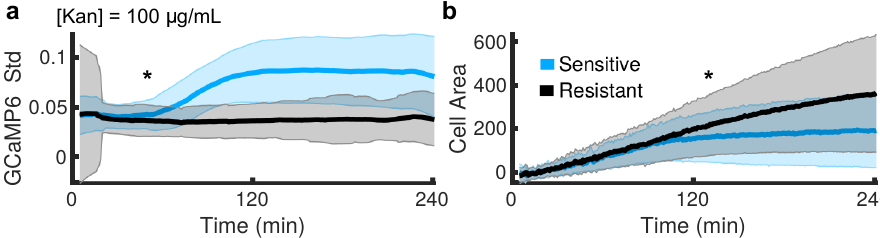
Figure 4. The onset of Ca 2 + transients precedes measurable growth defects at the population level in response to kanamycin. ( a , b ) Average (dark line) of single cell measurements for GCaMP6 std ( a ) and cell area ( b ) over time in 100 µ g/mL of kanamycin. The squared variance between single-cells for each time-point shown in shaded error bar. The sensitive (blue, 5011 total cells) and resistant (black, 3005 total cells) populations diverge in 50 min by Ca 2 + transients ( a ) while the divergence in cell growth ( b ) occurs at 131 min (asterisk, KS-statistic >